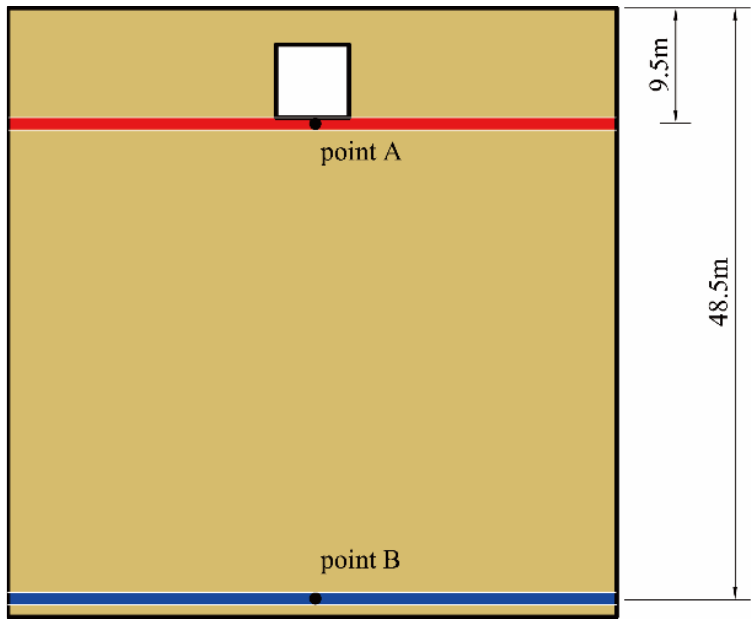
Figure 4. Layout of monitoring points when the tunnel is embedment at a depth of 6 m.